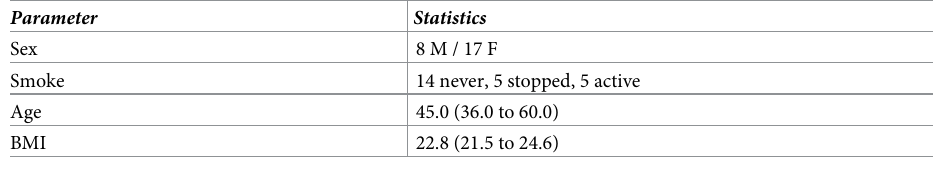
Table 4. Baseline characteristics of SARS-CoV-2 asymptomatic subjects. Median